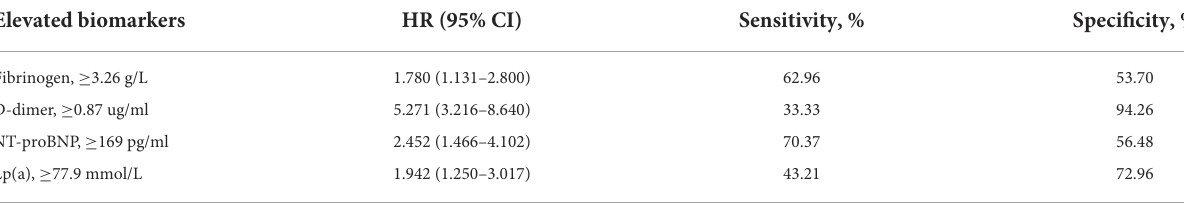
TABLE 3 Elevated biomarkers and risk of MACE after ACS.